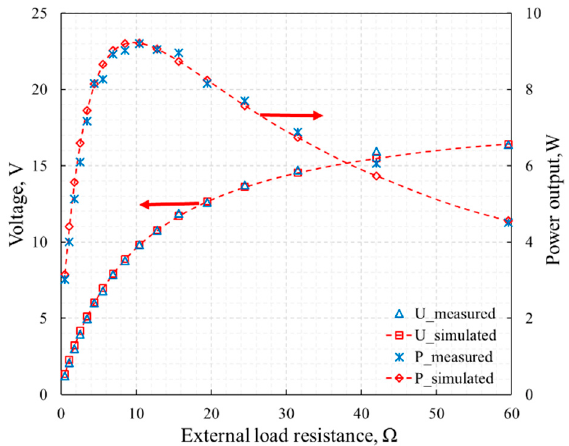
Figure 8. Validation of power output and TEG voltage with varying external load at V in = 1 m/s and